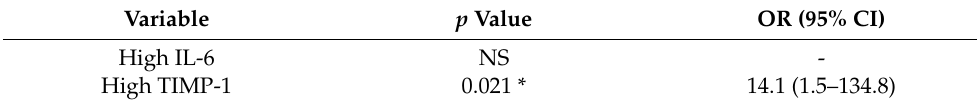
Table 6. Association of biomarkers in MPA with motor neuropathy in multivariable analysis. Variable p Value OR (95% CI) High IL-6